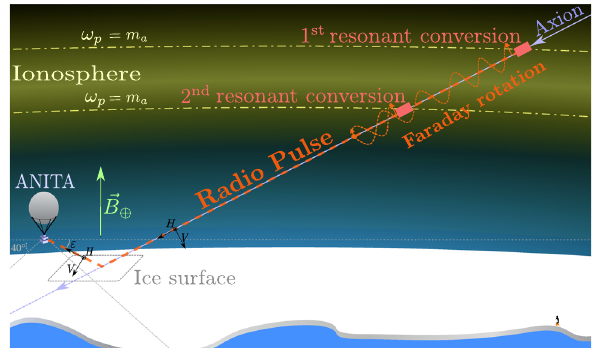
Fig. 4 Sketch of an axion burst arriving to the ionosphere, undergoing resonant conversion, Faraday rotation, and reflecting on the ice surface before reaching ANITA